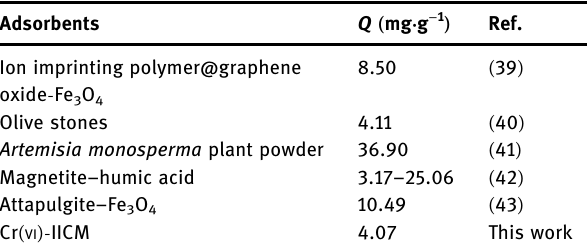
Table 9: Comparison of adsorption quantity by di ff erent materials